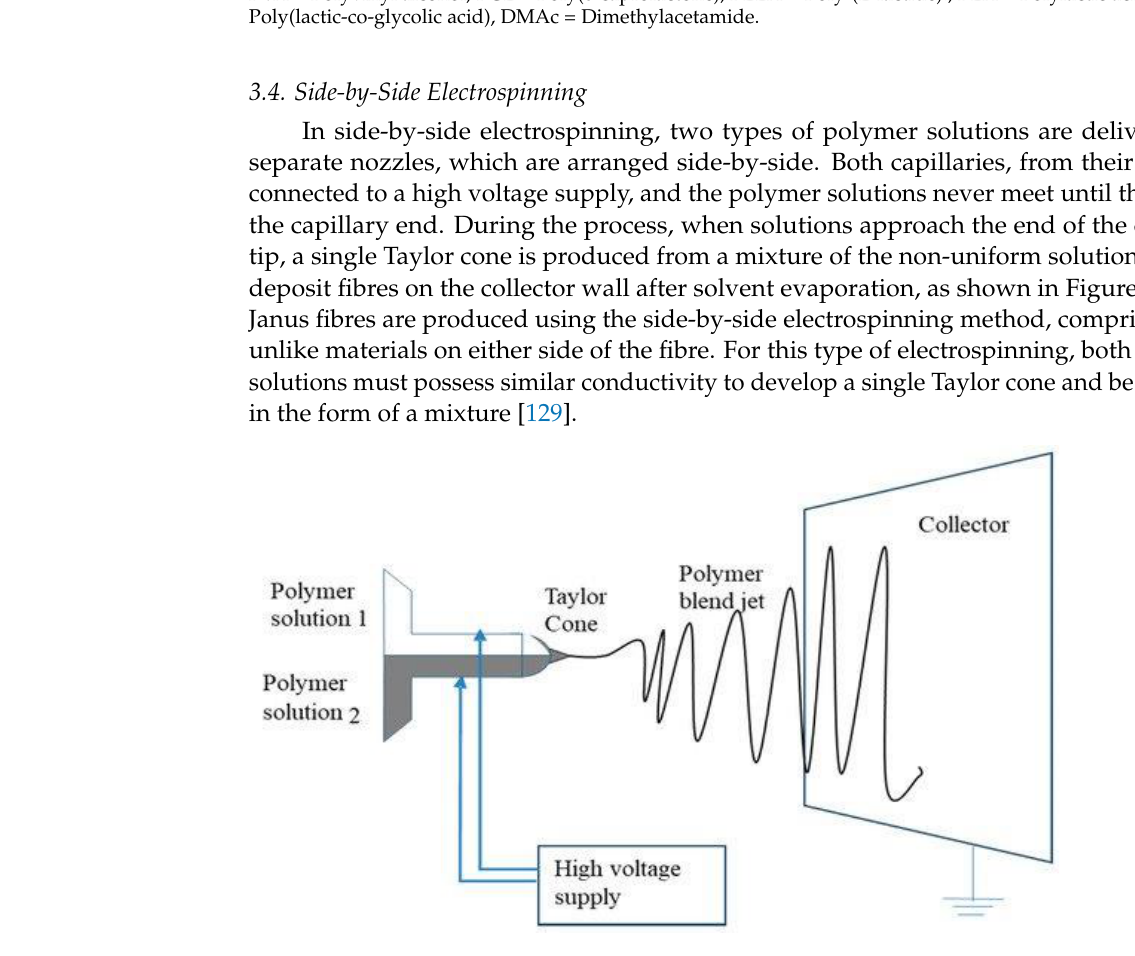
Figure 12. Side-by-side electrospinning schematic diagram. Reproduced with permission from [128], copyright 2019 MDPI.